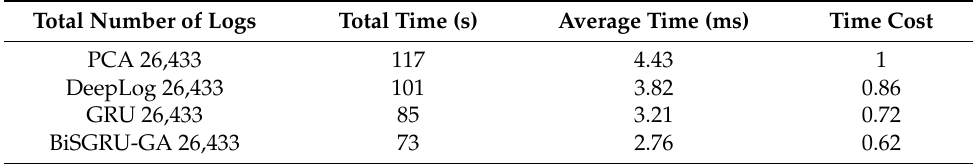
Table 4. Efficiency comparison of PCA, DeepLog, GRU.